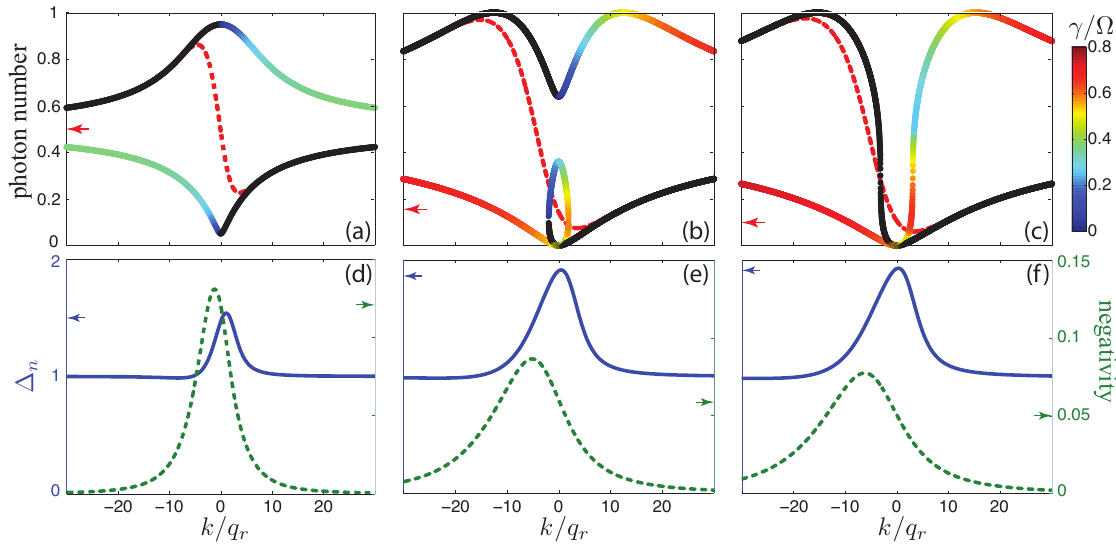
Figure 5. ( a ) ( c ) Photon number obtained from the mean-field approach (solid curves) and ∼ from quantum mechanical Master equation approach (red dashed curves). From ( a ) to ( c ), Ω = 3 κ , 5 . 6 κ , 6 κ . The color on the solid curves represents the normalized decay rate γ/ Ω of unstable mean-field states. The black color represents stable mean-field states. We have = κ , and other parameters are the same as in Figure 2. ( d ) used ε p photon number fluctuation (blue solid curve) and negativity (green dashed line) obtained from the quantum approach. The parameters used here are the same in ( a ) The horizontal arrows indicate results from the J-C model by taking q